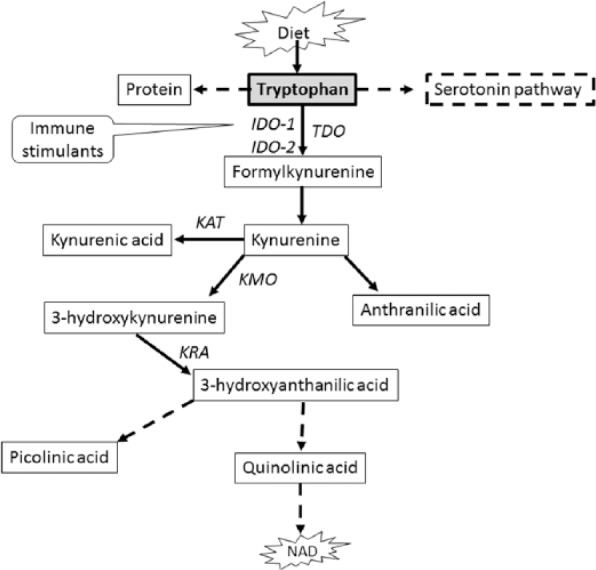
Simplified pathway of tryptophan metabolism in mammals.Dashed arrow indicates multiple processes. Solid arrow indicates single process. IDO-1, indoleamine 2,3-dioxygenase 1; IDO-2, indoleamine 2,3-dioxygenase 2; KAT, kynurenine aminotransferase; KMO, kynurenine 3-monooxygenase; KRA, kynureninase; NAD, nicotinamide adenine dinucleotide; TDO, tryptophan 2,3-dioxygenase.